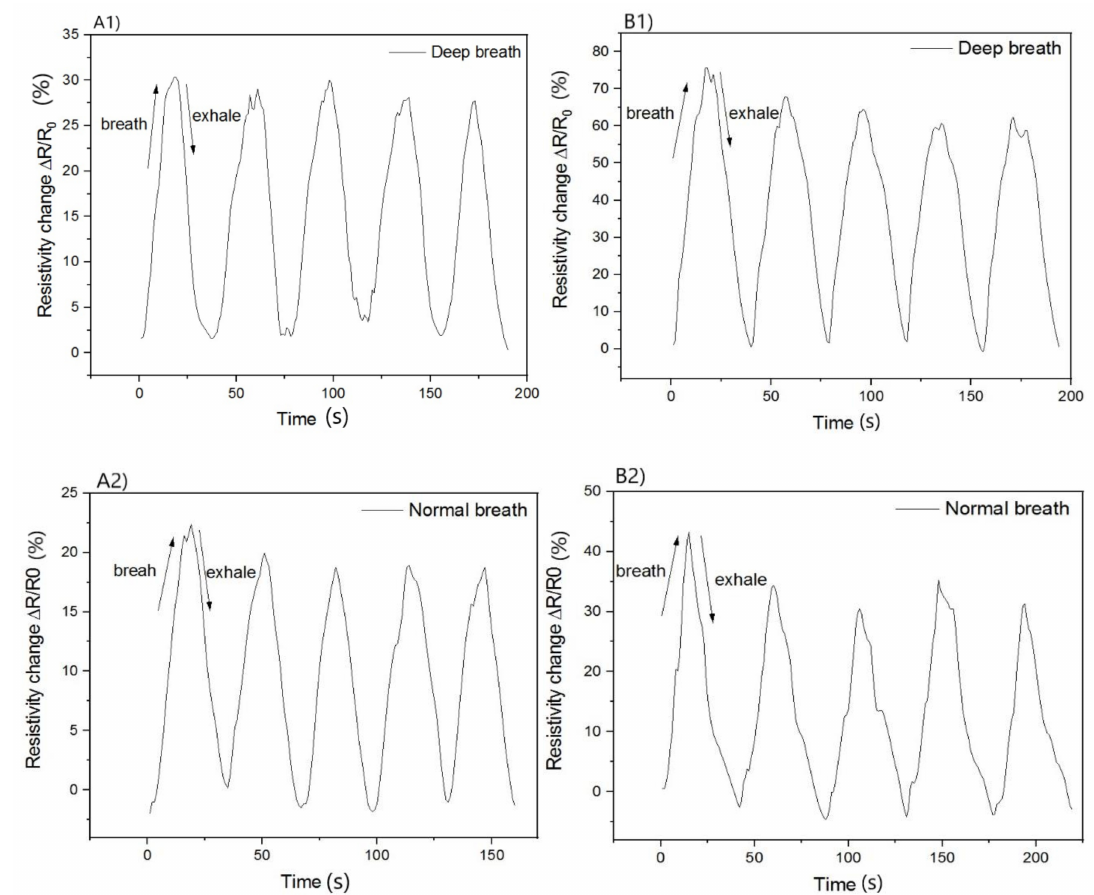
Figure 8. Response to a change in relative resistance, ∆ R / R 0 , of carbon nanotube sensors (MWCNTs / KMnO 4 ) integrated into the T-shirt to monitor human breath. The comparison of deep breath and normal breath for both volunteers ( A1 , A2 , B1 , B2